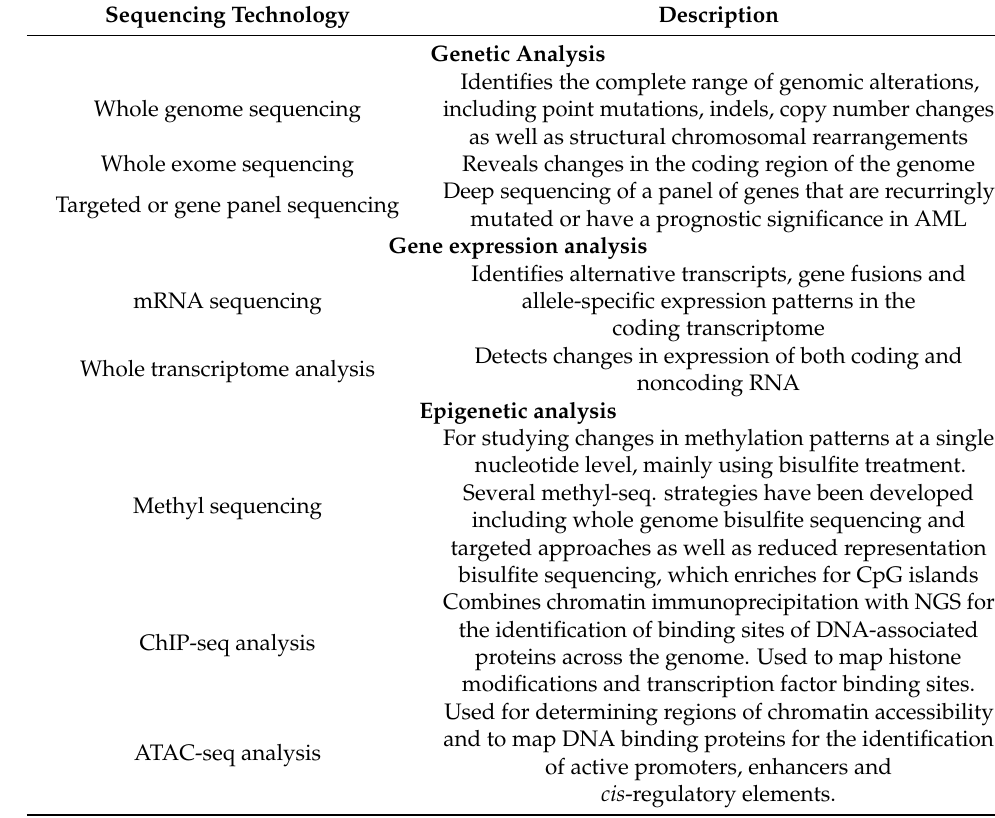
Table 1. An overview of the frequently used NGS technologies that have provided insights into the complex genetic, transcriptomic and epigenetic landscapes of AML (for a comprehensive review, refer to [87]). These techniques are used for the sequencing of bulk AML samples as well as for single-cell sequencing, depending on the aim of the